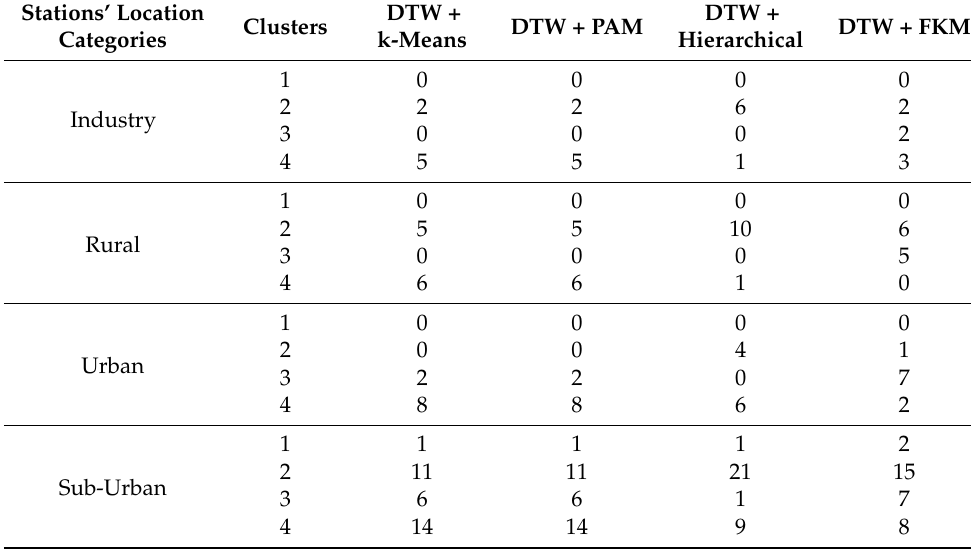
Table 6 indicates the crosstable of the number of stations between clusters formed for k-Means, PAM, agglomerative hierarchical, and FKM clustering algorithms with the stations’ location categories of the PM 10 daily maximum time series data. Most of the stations are grouped into clusters 4 and 2. The majority of the stations in the industrial area are grouped into cluster 4 based on k-Means, PAM, and FKM, while most of them are grouped into cluster 2 based on hierarchical algorithms. As for stations located in rural and sub-urban areas, most stations are members of cluster 4 according to k-Means and PAM, while most stations in this area are members of cluster 2 based on hierarchical and FKM algorithms. Most of the stations in urban areas are in cluster 4 based on k-Means, PAM and hierarchical, while the highest number of stations in urban areas are in cluster 3 based on the FKM algorithm. Based on this table, it can be deduced that the cluster from the daily maximum was independent of station categories. Table 6. Crosstable of the number of stations between clusters formed for each clustering algorithm with the stations’ location categories of the PM 10 daily maximum time series data.